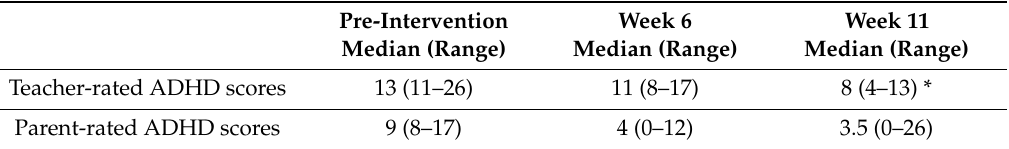
Table 1. The table shows the parent and teacher-rated Attention Deficit / Hyperactivity Disorder (ADHD), symptom scores for the children with ADHD ( n = 6) at each